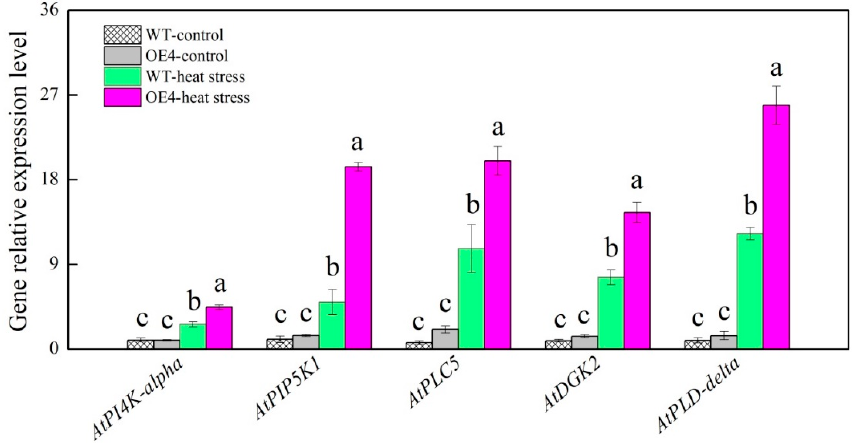
Figure 9. Changes in key genes involved in metabolic pathways of phosphoinositide (PI) and phosphatidic acid (PA) regulated by spermidine in leaves of Arabidopsis thaliana during heat stress. Vertical bars indicate ±SE of mean ( n = 4) and different letters above column indicate significant differences ( p ≤ 0.05) among treatments.